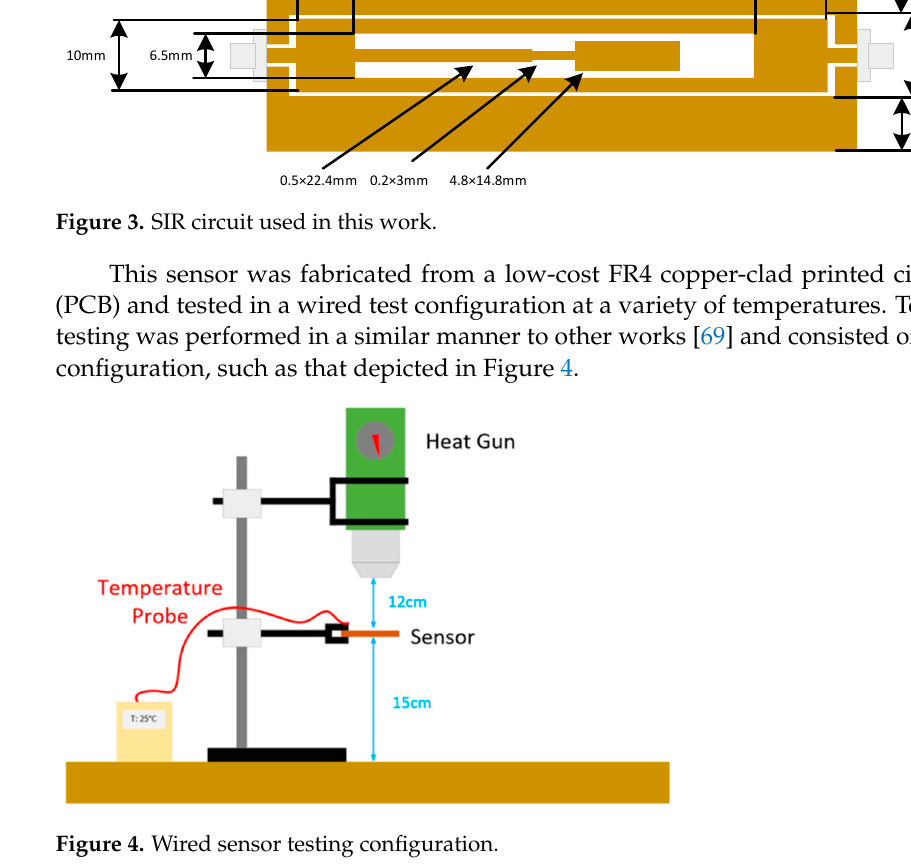
Figure 5. ELC resonator used in this work.